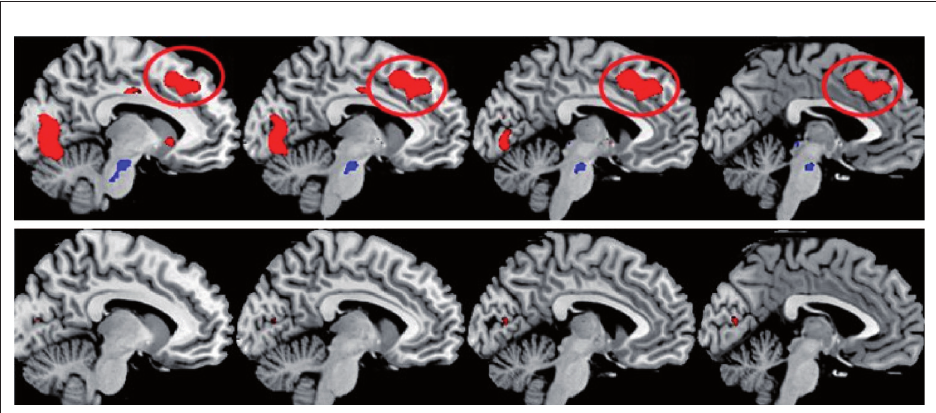
Figure 4 | fMRI activation data in a healthy control group (upper row) and patients with schizophrenia (lower row) when the images acquired during instructions to attend to the left ear stimulus were in contrast with the images acquired during instructions to attend to the right ear stimulus. The sagittal displays are from − 9 mm (furthest left display) to − 3 mm (furthest right display) from the midline, in the left hemisphere. The red ovals highlight the activation in the anterior cingulate cortex, which is a part of a proposed generalized effort network. Other areas included in the generalized effort network are prefrontal and parietal areas (not shown in the figure) as well as occipital areas ( p < 0.5,